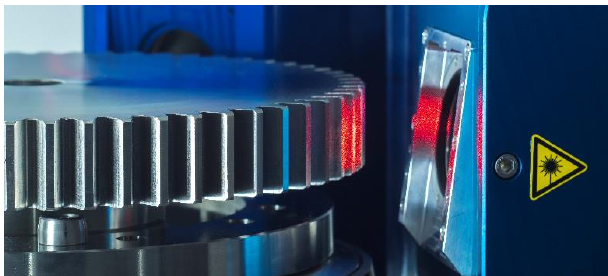
Figure 4. Experimental setup including the gear tooth sample and holography sensor.